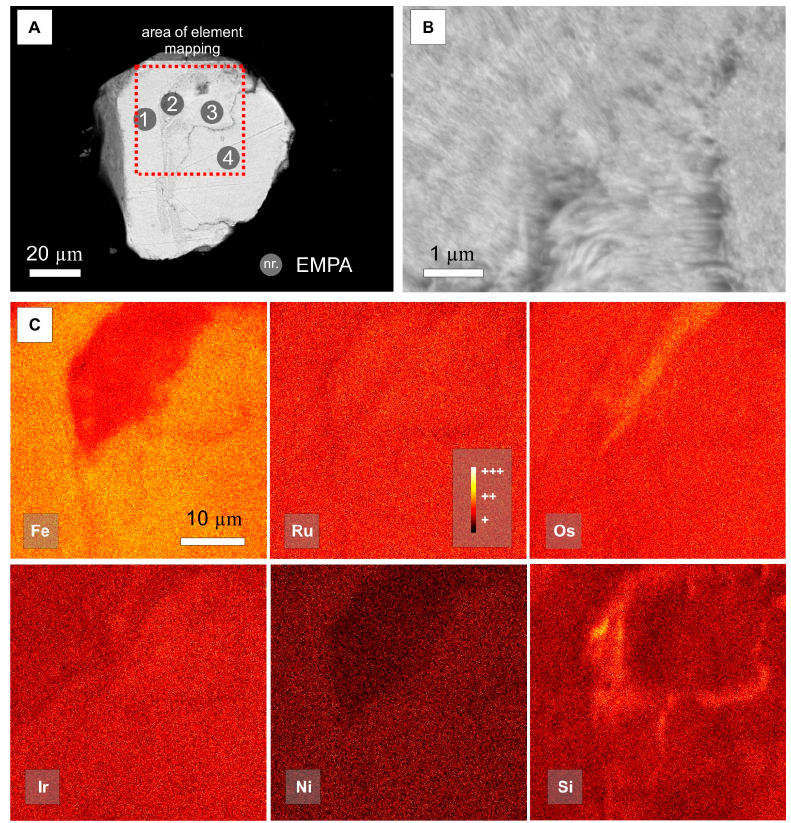
Figure 5. ( A ) BSE image of the polished fibrous PGM shown in Figure 3A with an indicated area of element mapping and points of EMP analyses (EMPA); ( B ) close-up of polished PGE-bearing nanofibers next to EMPA point 2; ( C ) element mapping; note the elevated Si contents where nanofibers are present. For details see the main